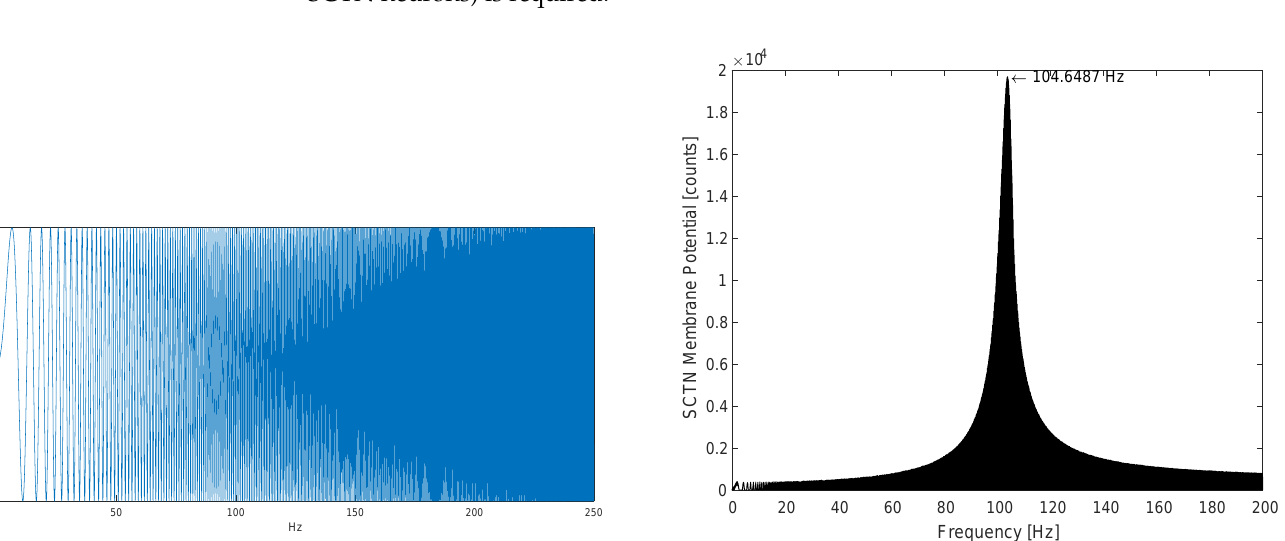
Figure 6. SCTN-based resonators’ bank (the parameters are tuned to detect 20 predefined frequencies in the audio spectrum).